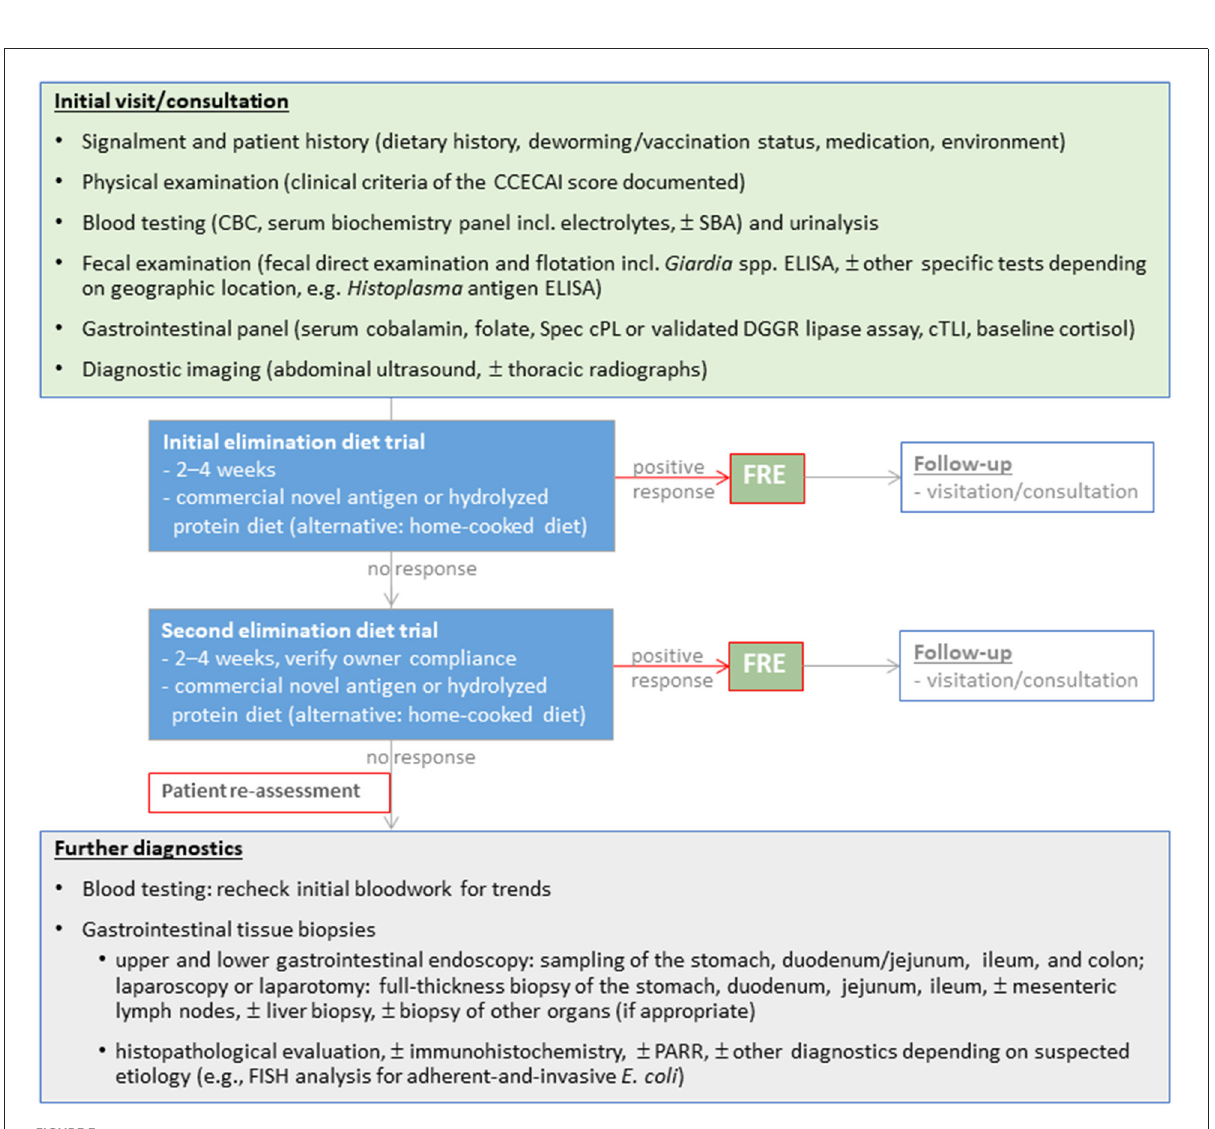
FIGURE3 Diagnostic evaluation of dogs suspected with chronic inflammatory enteropathy (CIE). Selection and sequence of the individual diagnostic steps might vary and have to be tailored to the individual